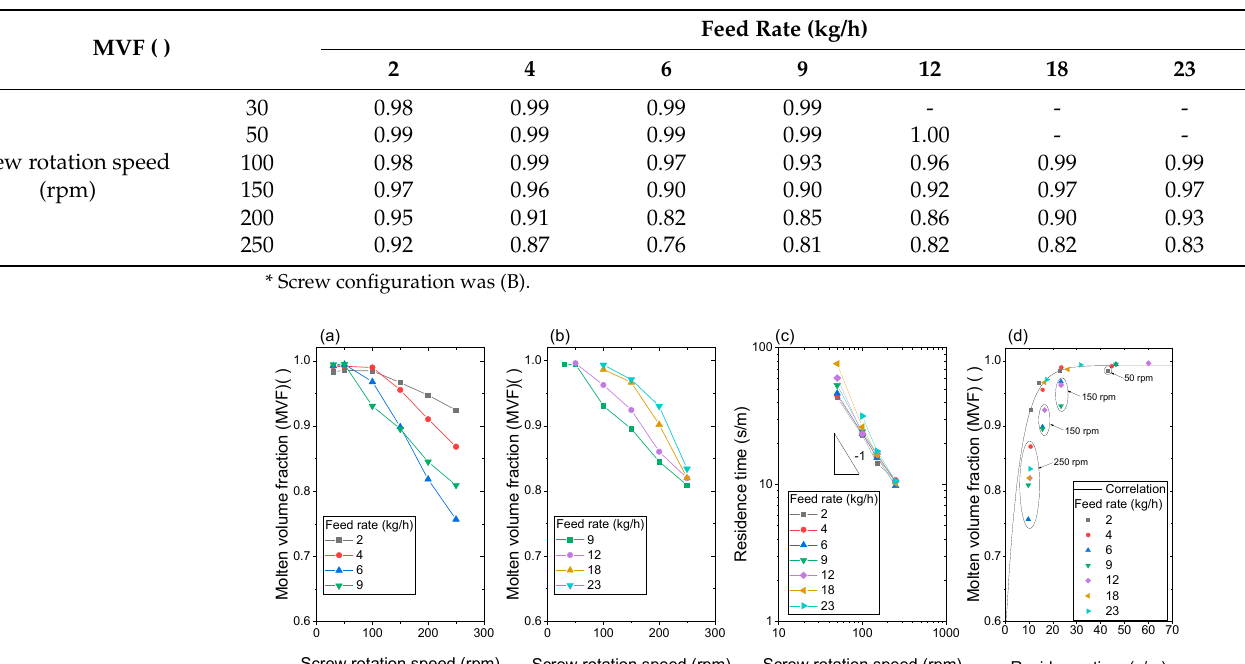
Table 2. Summary of molten volume fraction (MVF) dependence on increasing screw rotation speed at constant feed rates: 1st series *.